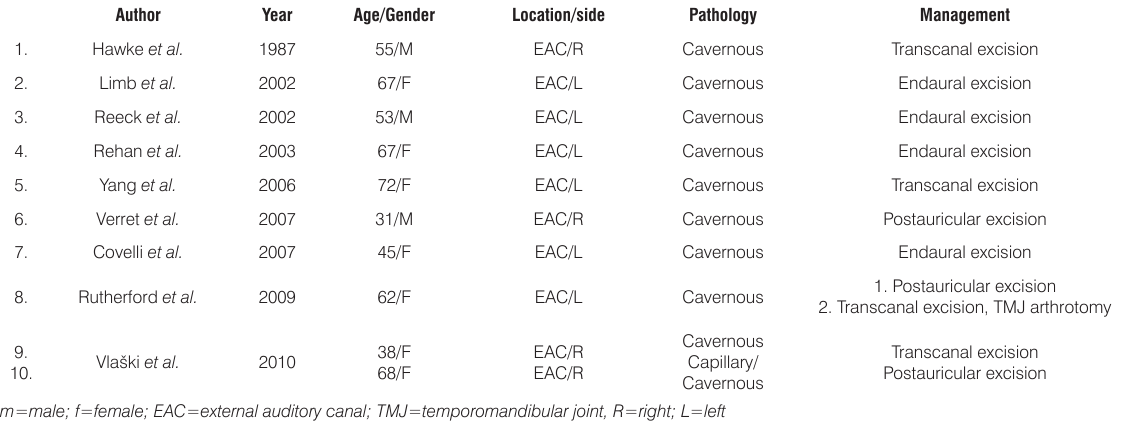
Table 1. Hemangiomas of the external auditory canal – literature